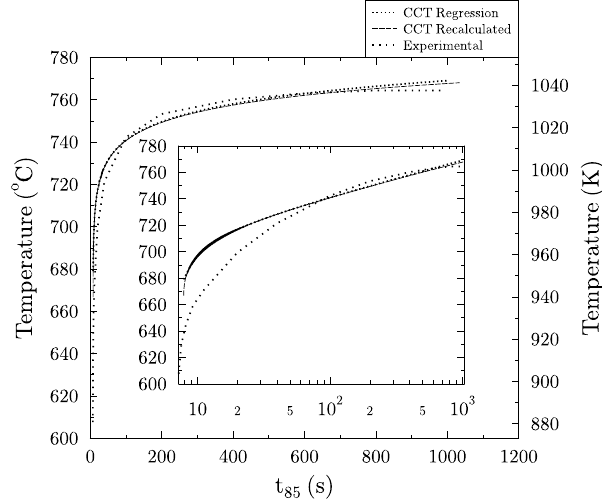
Figure 4. To validate the model, the CCT diagram was recalculated from the ideal (or true) TTT curve using Scheil’s additivity rule. The result shows excellent agreement between the original CCT curve calculated from Equations (1) and (2) and the recalculated CCT curve. The results were also compared to the experimental data given in [22]. Note that the original CCT curve and the recalculated curve almost